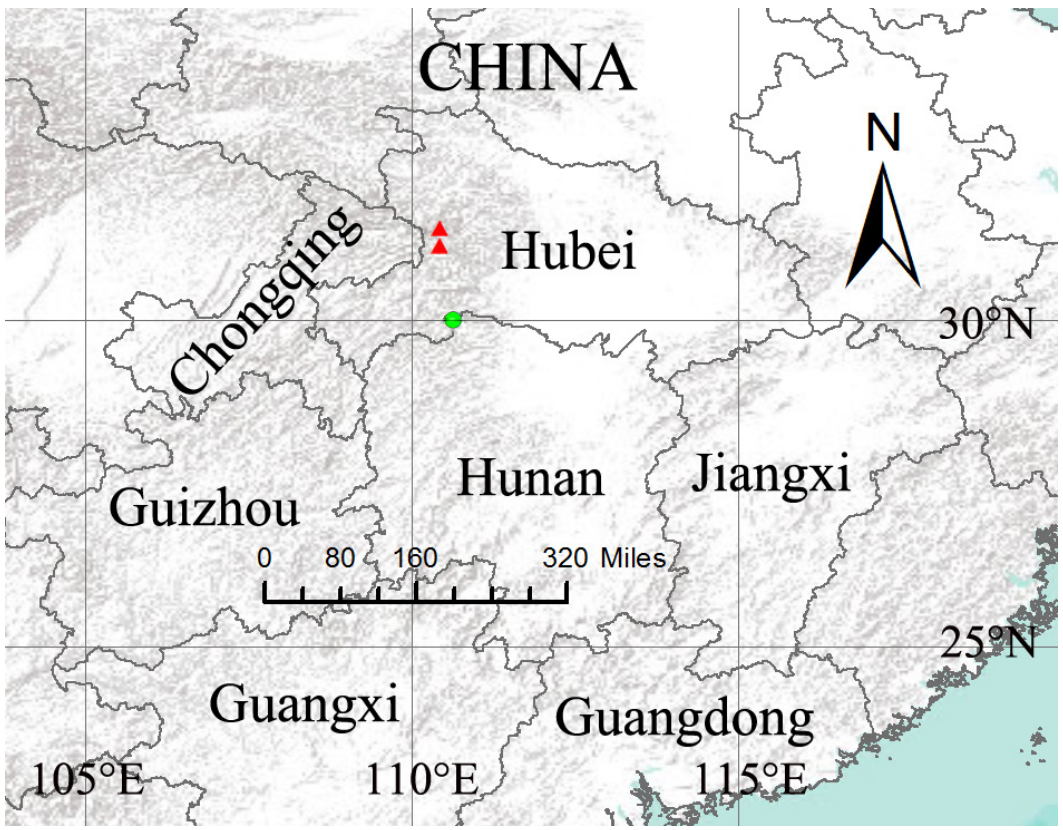
Fig. 3. Distribution records of Yaginumaella hubeiensis sp. nov. (red triangles) and Y. pulchella sp. nov. (green